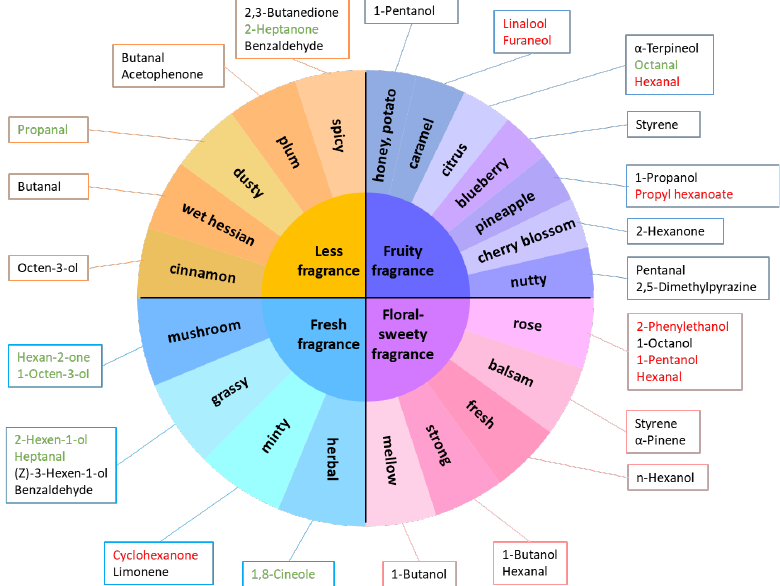
Figure 5. Key VOCs forming the four characteristic aroma types. Compounds marked in red indi- cate that the highest content was at high grade PCT, and those marked in green indicate that the highest content was at low grade